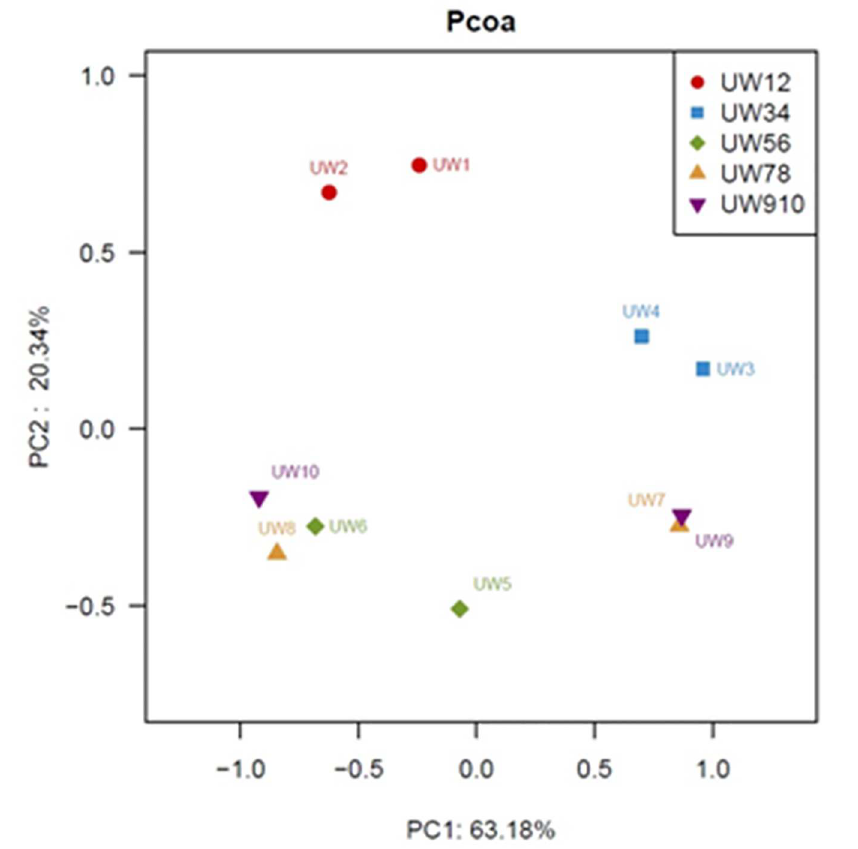
Fig 4. PCoA plot of weighted UniFrac distances of ten